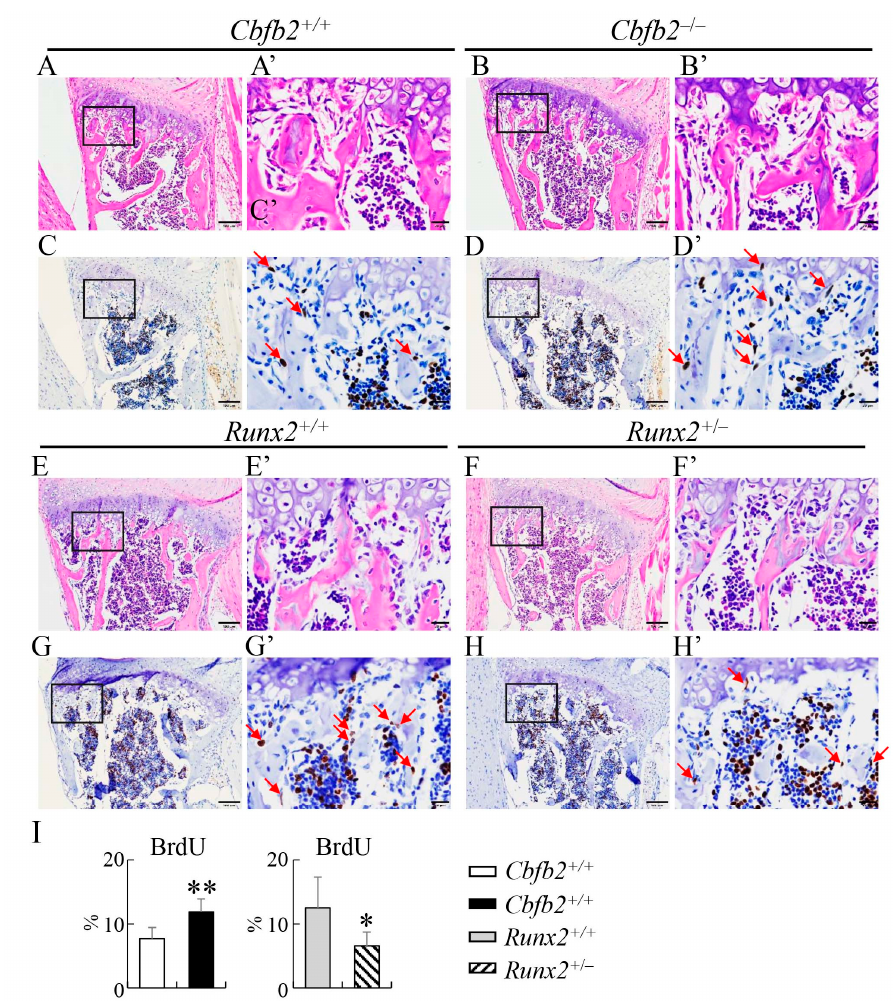
Figure 17. Proliferation of osteoblast-like and osteoprogenitor-like cells in vertebrae. ( A – H ) H-E staining ( A , B , E , F ) and BrdU staining ( C , D , G , H ) of the sections of 1st lumbar vertebrae in Cbfb2 +/+ ( A , C ), Cbfb2 –/– ( B , D ), Runx2 +/+ ( E , G ) and Runx2 +/– ( F , H ) mice at 4 weeks of age. The boxed regions in ( A – H ) are magnified in ( A’ – H’ ), respectively. Arrows in ( C’ , D’ , G’ , H’ ) show osteoblast ‐ like or osteoprogenitor ‐ like cells. Scale bars: 100 μ m ( A – H ) and 20 μ m ( A’ – H’ ). ( I ) The frequencies of BrdU ‐ positive osteoblast ‐ like and osteoprogenitor ‐ like cells, which were counted in ( C’ , D’ , G’ , H’ ). Data are shown as the mean ± SD. * p < 0.05, ** p < 0.01. The number of mice analyzed: Cbfb2 +/+ , n = 3; Cbfb2 –/– , n = 3; Runx2 +/+ , n = 3; Runx2 +/– , n = 4. Two regions were counted in each mouse.